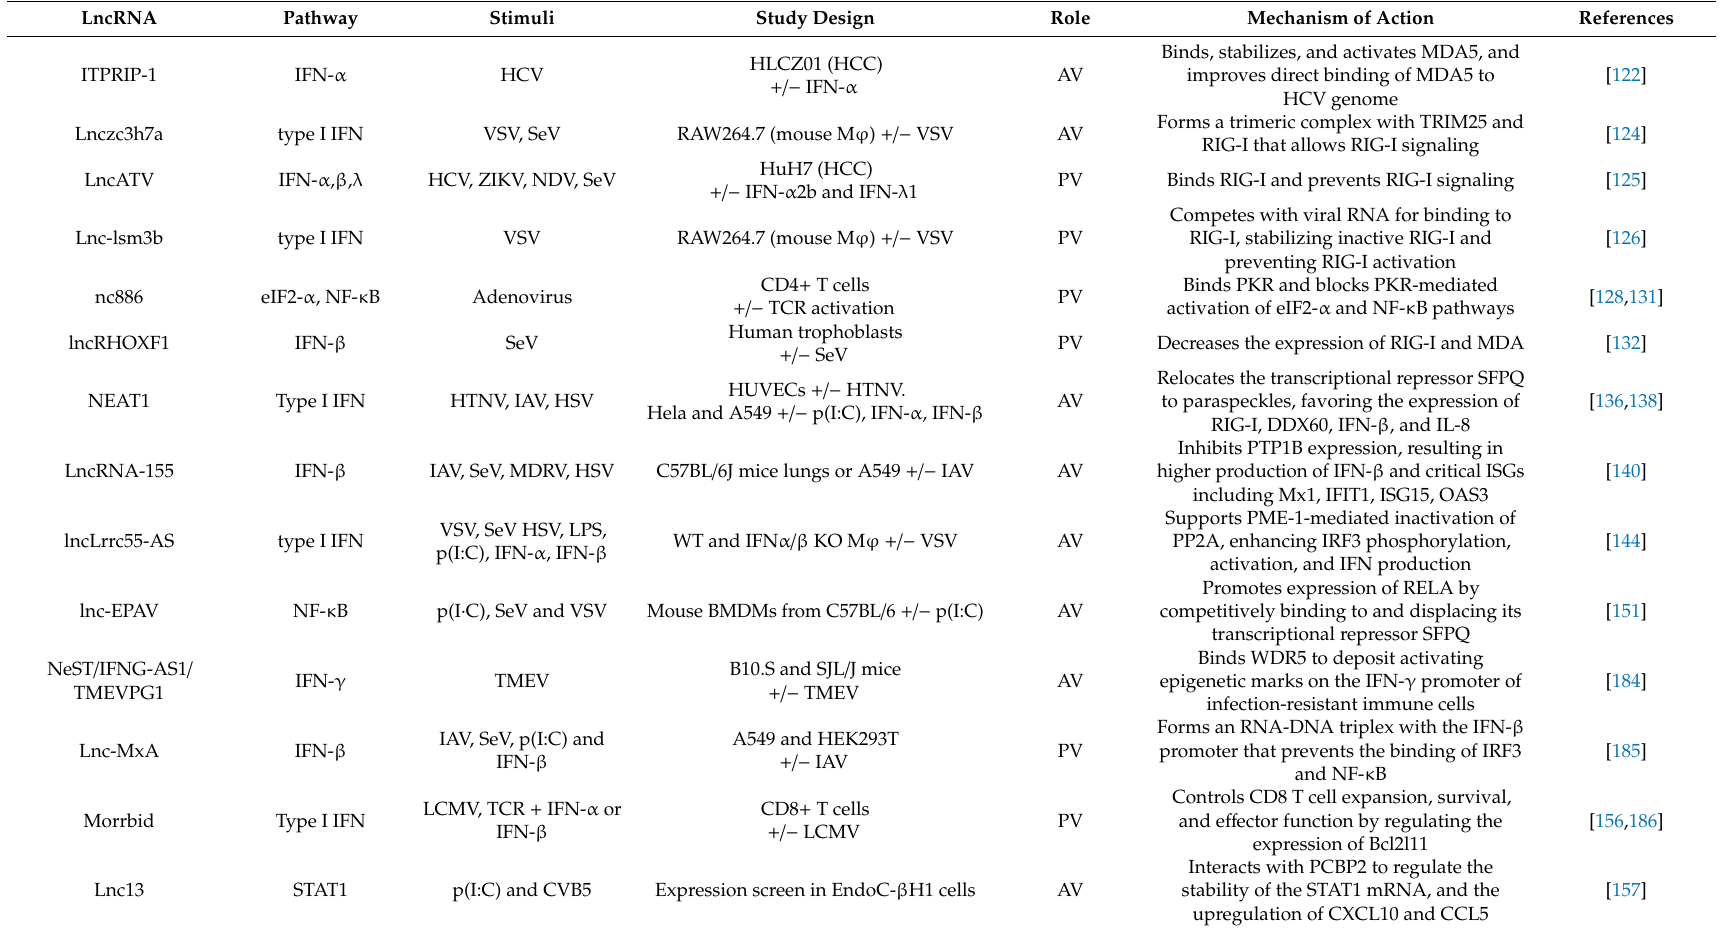
Table 2. LncRNAs deregulated by viral infections and involved in the innate antiviral immune